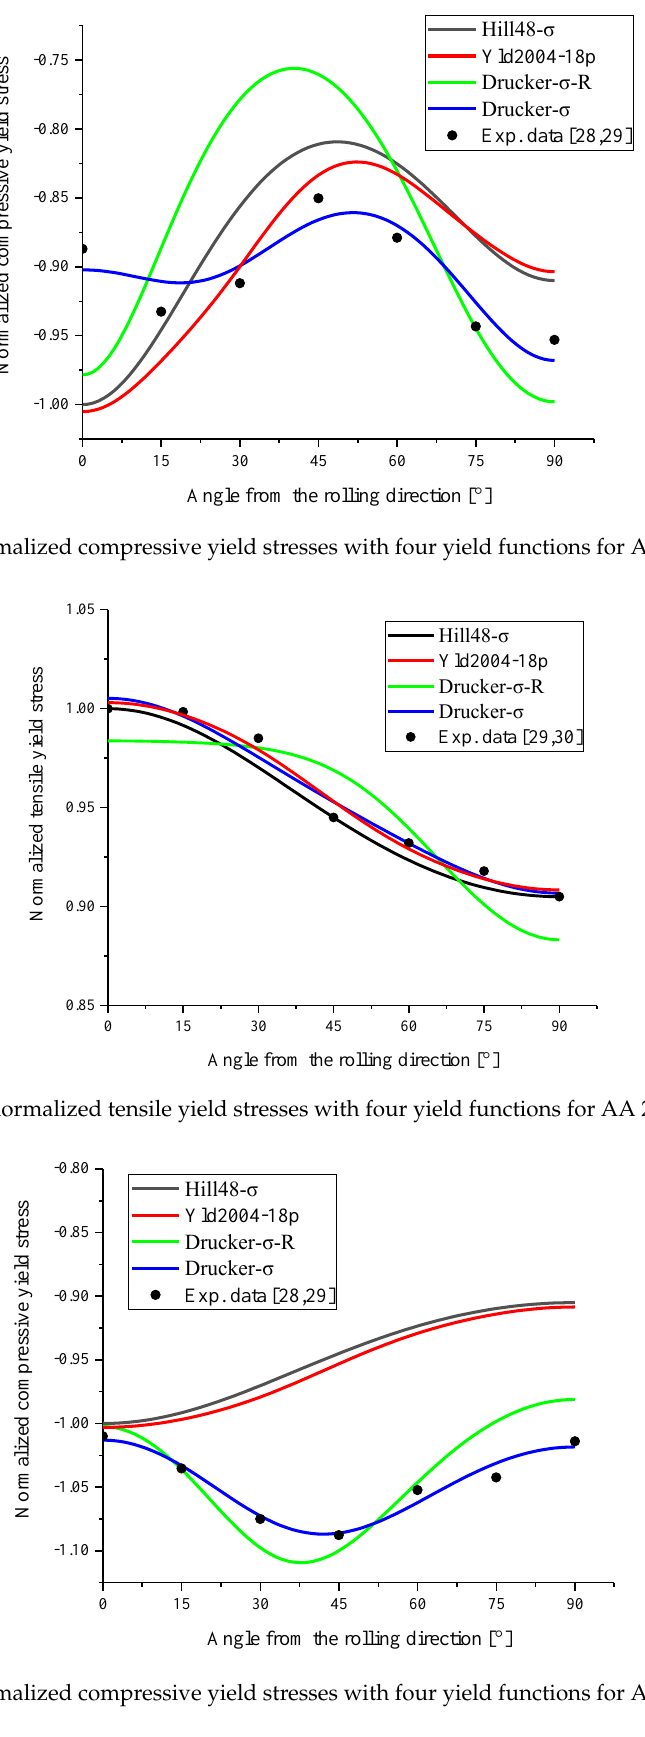
Figure 3. The normalized tensile yield stresses with four yield functions for AA 2090-T3 sheet.